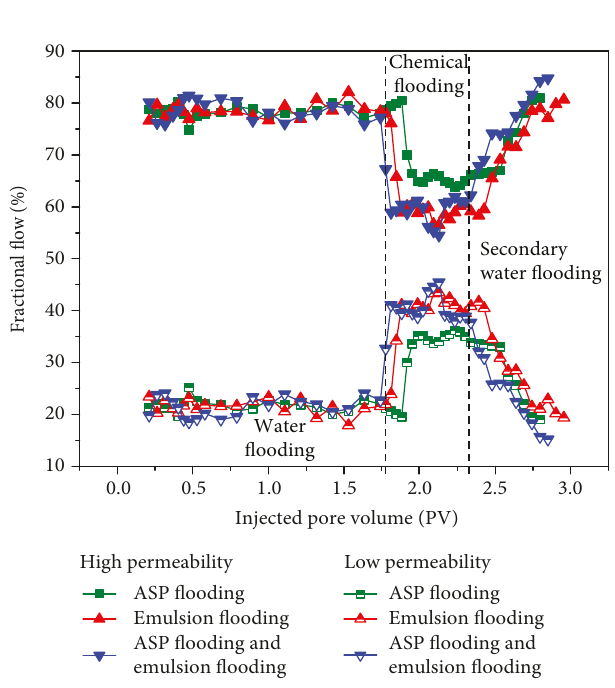
Figure 12: Fractional fl ow of each layer for di ff erent chemical fl